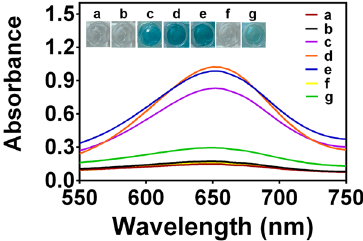
Fig. 3 UV – Vis absorption spectra and photographs of different reaction systems. TMB + H 2 O 2 ( a ), COF + TMB + H 2 O 2 ( b ), AuNPs + TMB + H 2 O 2 ( c ), COF-AuNPs + TMB + H 2 O 2 ( d ), apt-COF-AuNPs + TMB + H 2 O 2 ( e ), apt-COF-AuNPs + TMB ( f ), apt-COF-AuNPs + S. typhimurium + TMB + H 2 O 2 ( g ). Reaction conditions were COF (0.2 mg/mL), COF-AuNPs (0.2 mg/mL), and apt-COF-AuNPs (0.2 mg/ mL), S. typhimurium (1 × 10 7 CFU/mL), TMB (2 mM) and H 2 O 2 (2 M) at 37 °C.